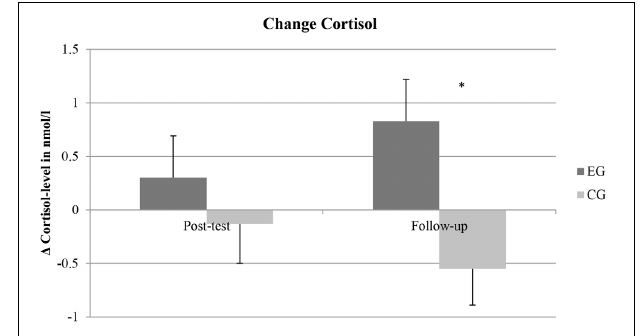
FIGURE 4 | Representation of means and error bars (representing standard error of the mean) for inhibition in the responder (subjects showing a cortisol elevation between pre- and post-test) and in the non-responder (subjects showing no or a negative change in cortisol level between pre- and post-test) group within the experimental group over the three measurement points (pre-test, post-test, follow-up). RT , reaction